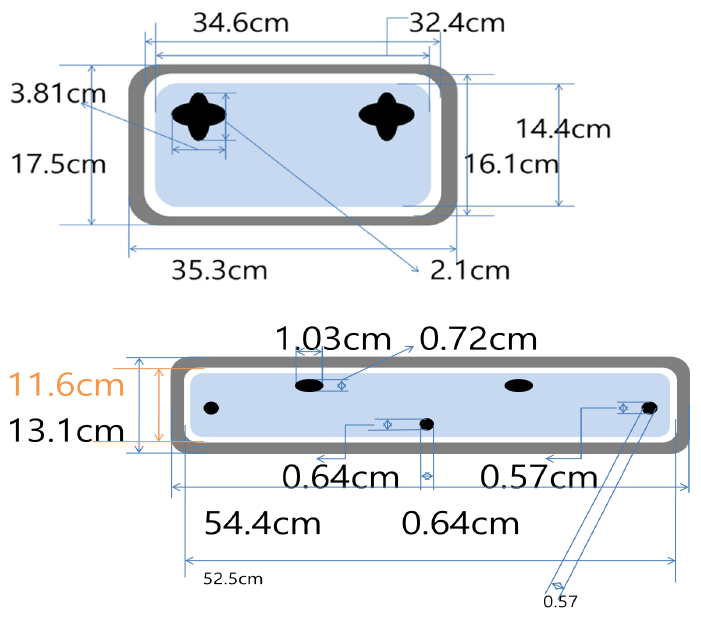
Figure 1. Size of a typical license plate holder. [26].